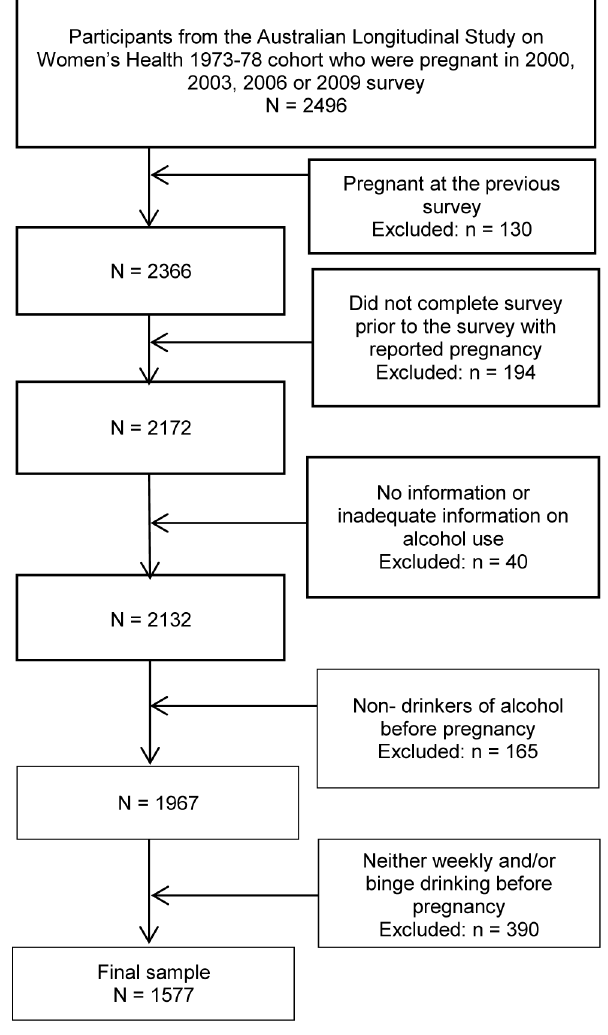
Figure 1. Flowchart of the sampling procedure. This includes the exclusion criteria used to draw the sample of women from the Australian Longitudinal Study on Women’s Health 1973–78 cohort.